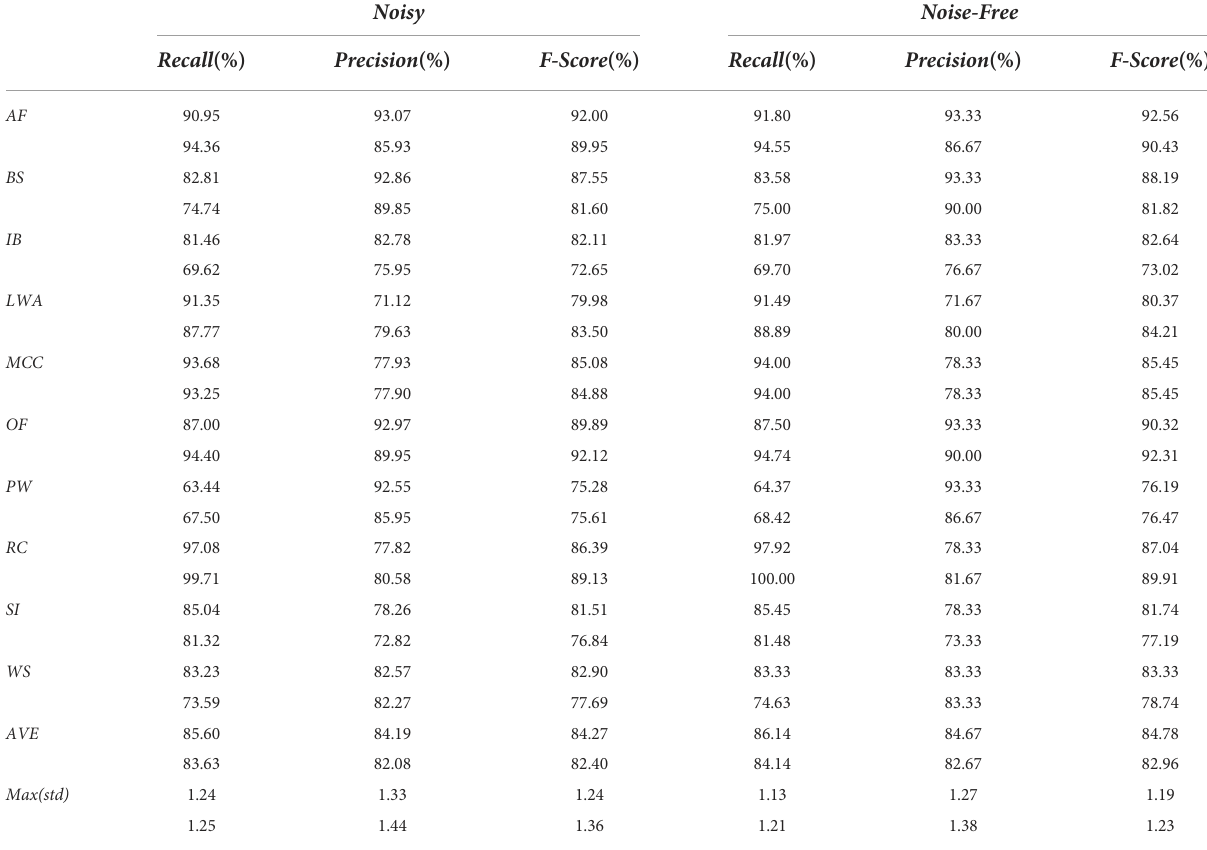
TABLE 5 Classi fi cation performance (%) in WV1 (upper) and WV2 (lower) imagette recognition for KECANet using noisy and noise-free datasets. Noisy Recall